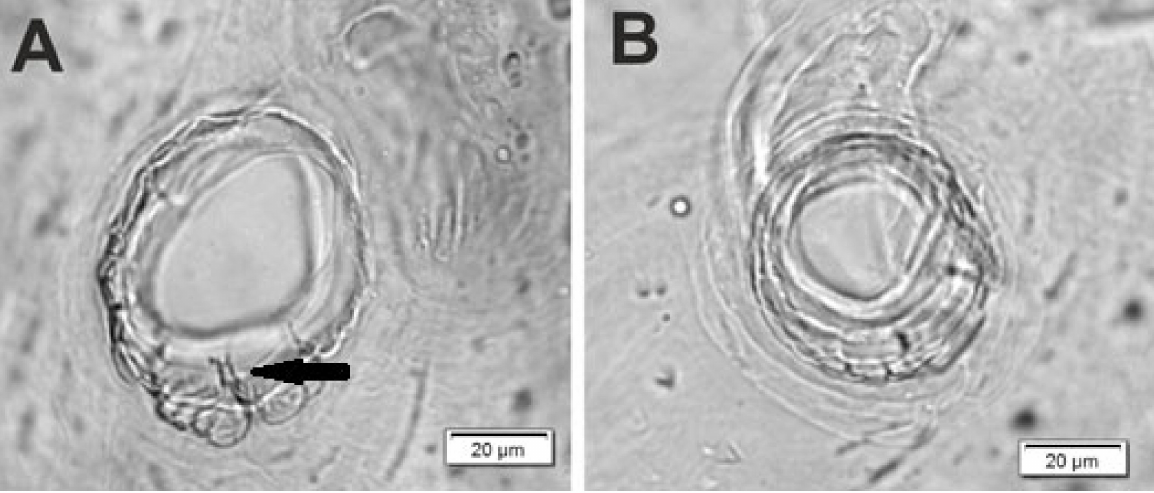
Figure 3. Lachnaeus crinitus mature larva, spiracles. ( A )—spiracle of prothorax; ( B )—spiracle of abdominal segment I. Head capsule rounded (Figure 4A,B). Endocarinal line absent. Frontal sutures distinct in entire length up to antennae. A single pair of stemma (st) in the form of prominent dark pigmented spots with convex corneas, placed anterolaterally (Figure 4A). Hypopharyngeal bracon without median sclerome. Setae of head of various lengths, elongated to minute. Des 1 elongated, placed medially; des 2 elongated, placed posterolaterally; des 3 elongated, placed above frontal suture; des 4 medium, placed anteromedially; des 5 elongated placed anterolaterally, and des 6 elongated, placed above stemma. Fs 1 medium, placed posteriorly; fs 2 medium, placed mediolaterally; fs 3 medium, placed medially; fs 4 elongated, placed anteromedially; and fs 5 elongated, placed anterolaterally, close to epistome. Les 1 and les 2 slightly shorter than des 1 . Postepicranial area with four minute pes (Figure 4B). Anten- nae (Figure 5A,B) with oblique positions on each side at anterior margins of the head; membranous basal segment convex, semi-spherical, bearing conical, relatively elongated sensorium and four sensilla ampullaceum (sa). Clypeus (Figure 6A–C) approximately 3.7 × wider than long, cls 1 and cls 2 medium, equal in length, elongated, sensillum (clss) placed between them; anterior margin of clypeus rounded to inside. Labrum (Figure 6A–C) ap- proximately 1.7 × wider than long, anterior margin strongly sinuated; lrs 1 and lrs 2 placed anteromedially, lrs 3 placed anterolaterally, all lrs elongated, equal in length. Epipharynx (Figure 6A,B) with three elongated, finger-like als , of various lengths; three finger-like ams : ams 1 short, ams 2 medium, ams 3 relatively elongated; mes 1 distinctly smaller than mes 2 both placed anteriorly; labral rods (lr) kidney-shaped, placed parallel; a single pair of sensillae pores (snp) arranged in the posterior part; surface smooth. Mandibles (Figure 6D) with two apical teeth of unequal height, the inner one subapical and much smaller; an additional protruding protuberance on the cutting edge between the apex and the